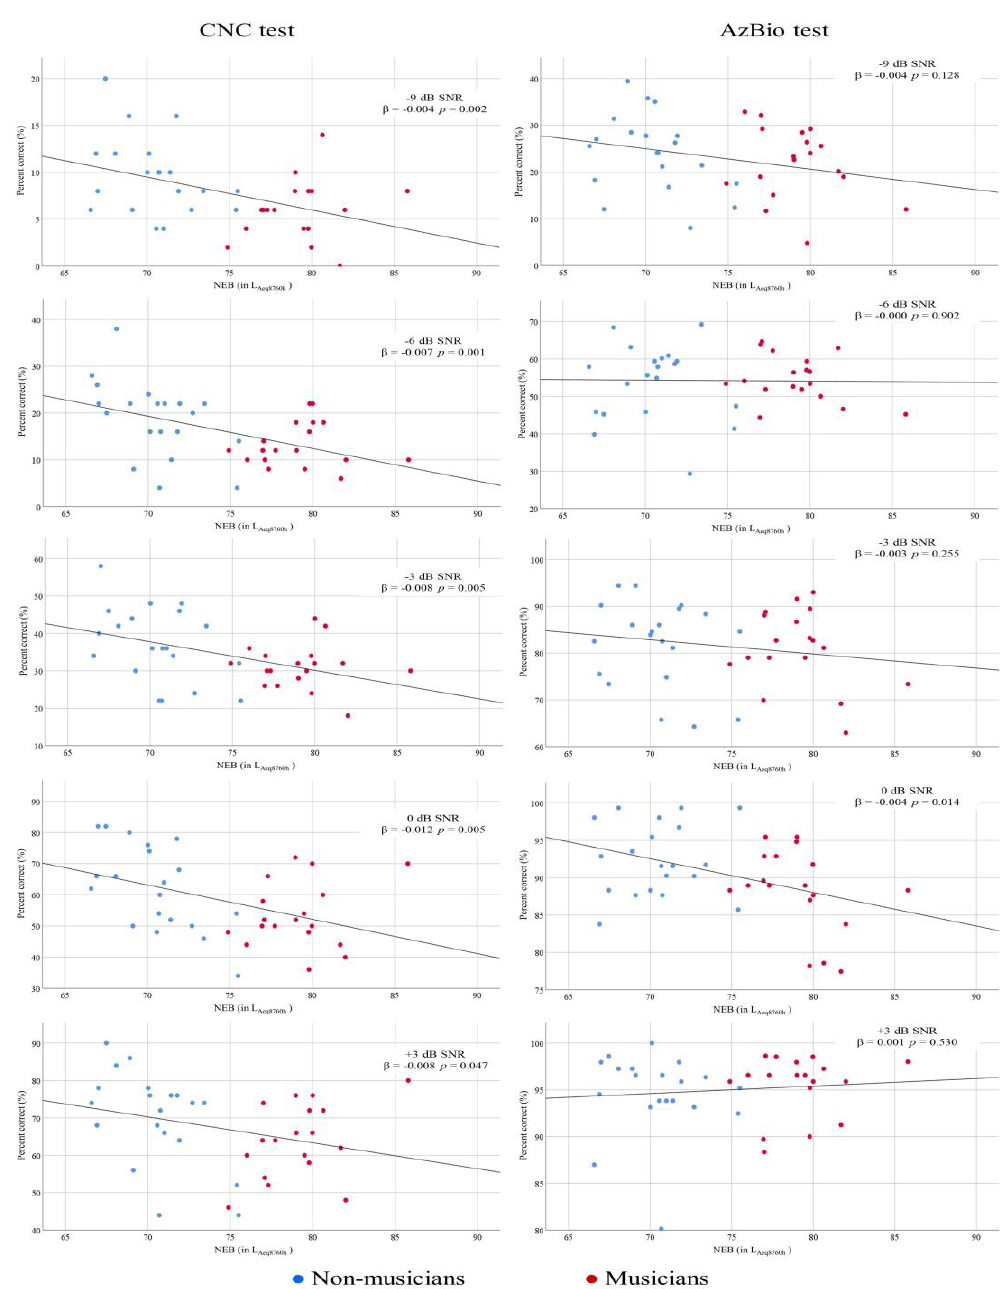
Figure 5. Scatter plots for NEB and CNC test performance ( left panel) and NEB and AzBio test performance ( right panel). Linear regression lines were inserted to show the predictive relationship. The signal to noise ratio (SNRs) is denoted in each panel ( − 9, − 6, − 3, 0, and +3 dB SNR). Regression results are shown in each